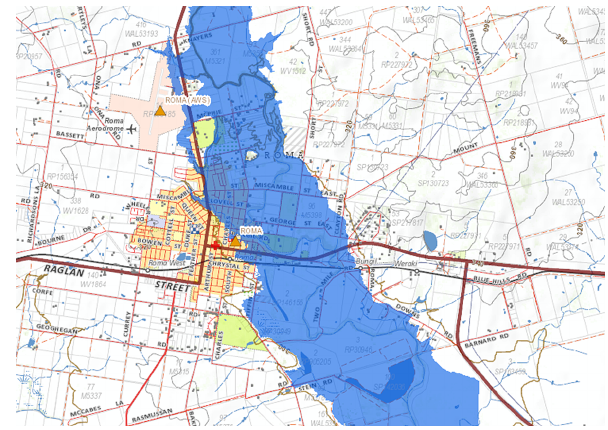
Figure 7. Boundary of the 2012 historic flood event (Queensland Department of Natural Resources and Mines,